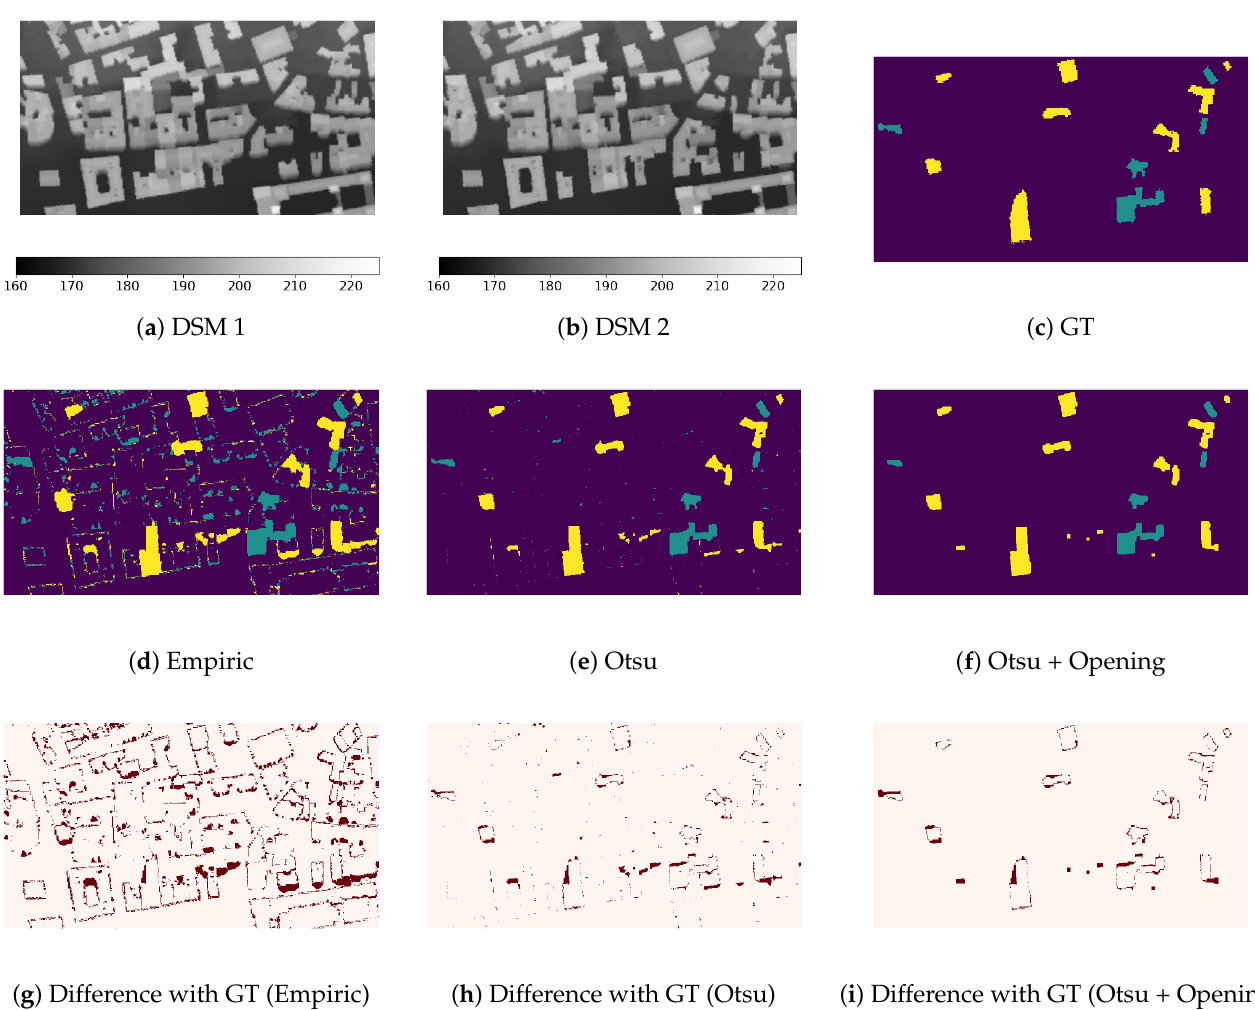
Figure 7. Results at the 2D pixel level for sub-dataset 1.b (ALS, low resolution). ( a , b ) DSMs with their elevations in meters and ( c ) ground truth (GT) with the following color code: purple for unchanged parts, blue for newly built parts and yellow for demolished parts. Results of DSMd with empirical thresholding ( d ), thresholds from the Otsu algorithm ( e ) and post-processing with an opening filter ( f ). Respective errors maps ( g – i ) highlight the differences (in red) from the ground